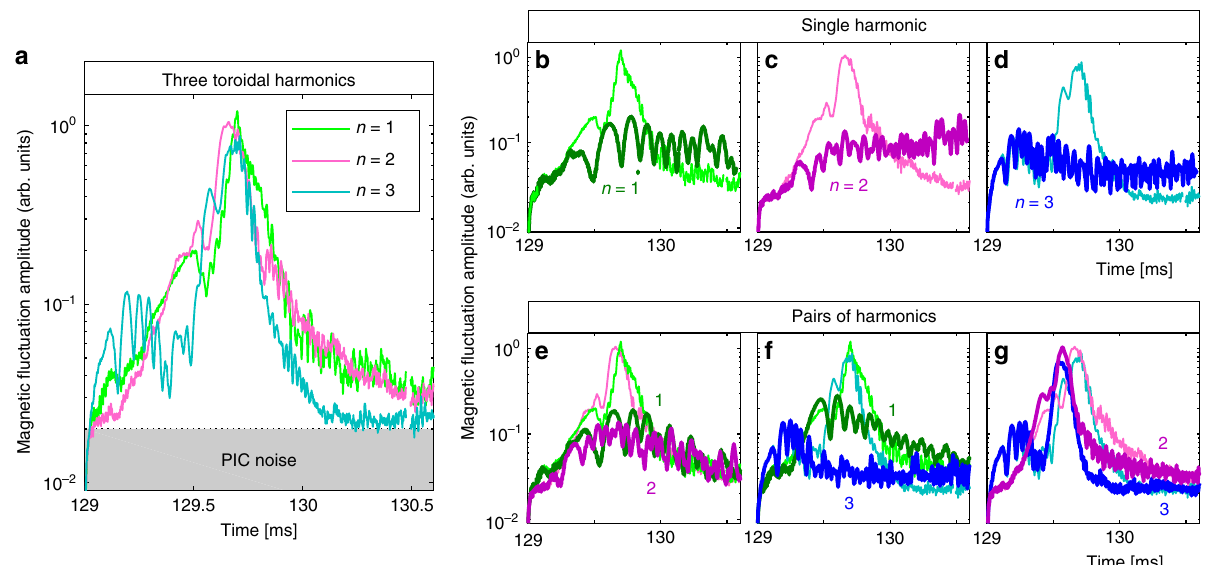
Fig. 5 Numerical prediction of the multi-mode nature of ALEs. The time interval 129 ms ≤ t ≤ 131.6 ms around the second ALE in the B 0 = 1.16 T case of Fig. 3 was simulated again without beam injection and without collisions, but with continuous MHD activity. The magnetic fl uctuation signal δ (cid:1) B decomposed into Fourier harmonics with toroidal mode numbers n = 1,2,3, whose time traces are shown in panel a . This simulation was then repeated six more times, while keeping only one harmonic at a time or pairs of harmonics: b n = 1, c n = 2, d n = 3, e n = 1 and 2, f n = 1 and 3, g n = 2 and 3. For comparison, the respective time traces from a are plotted once more in b – g as light-coloured